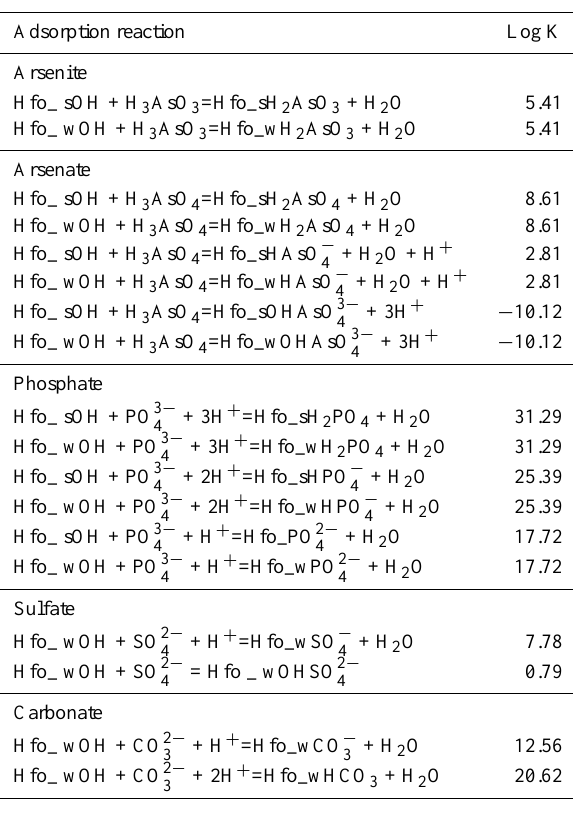
Table 4. Comparison of experimental and simulated amount of As desorption from core samples after 30